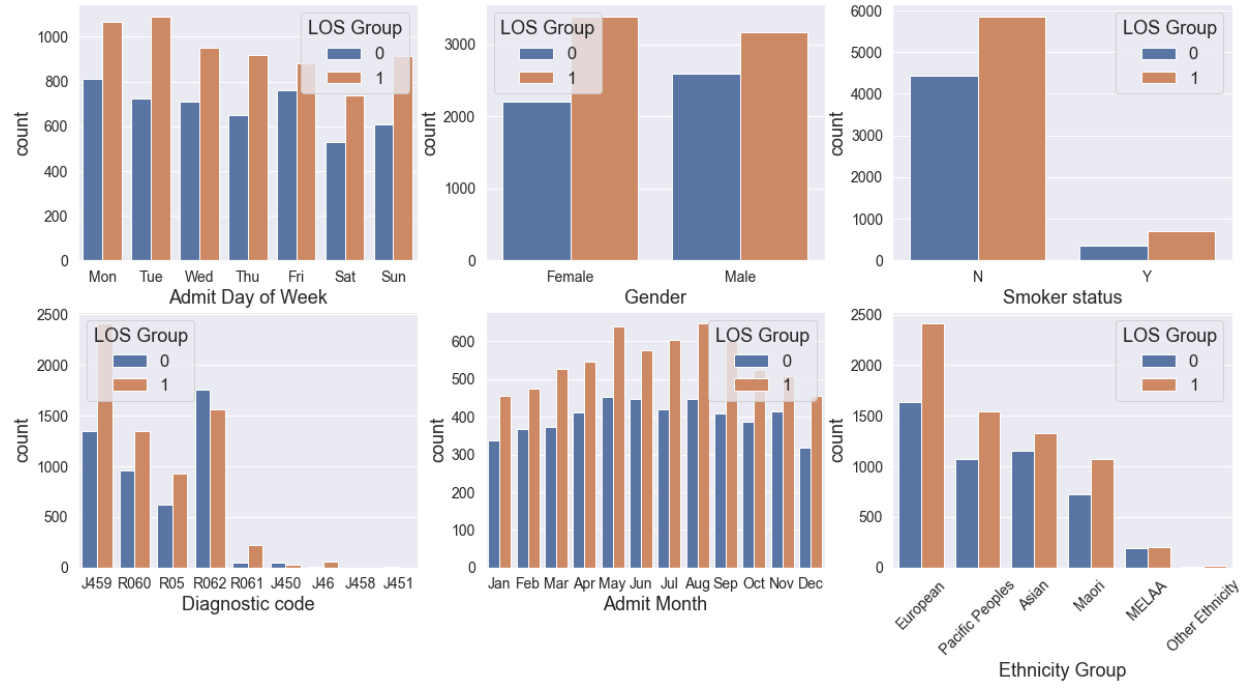
Figure 3. Distribution of feature values among the LOS groups.